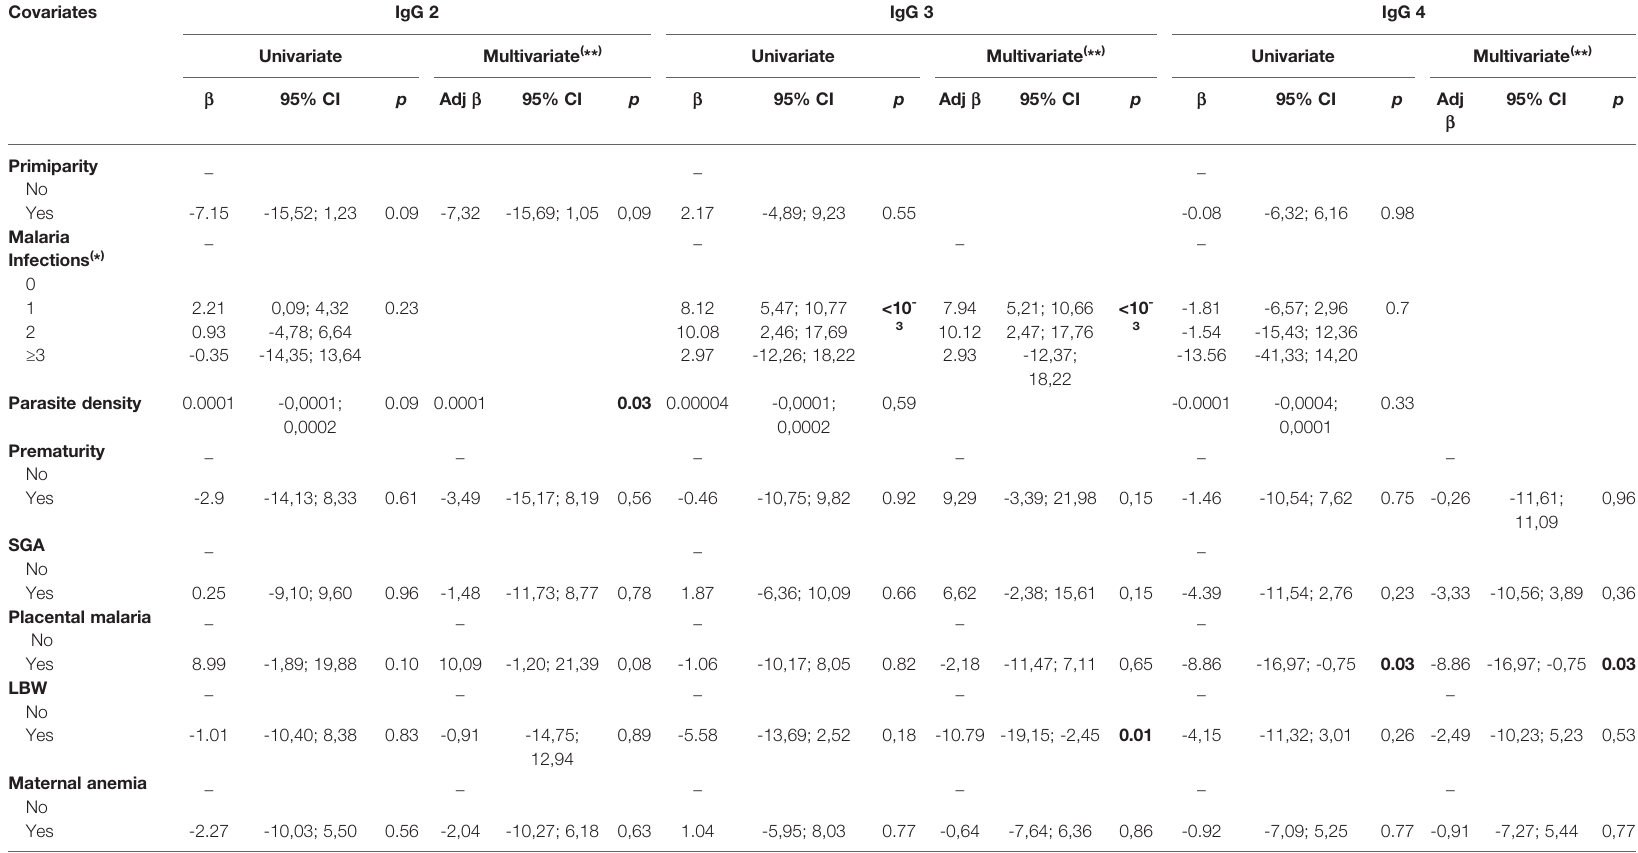
TABLE 3 | Relationship between antibody levels to ID1-ID2a construct of VAR2CSA and pregnancy outcomes (IgG2, IgG3 and IgG4).